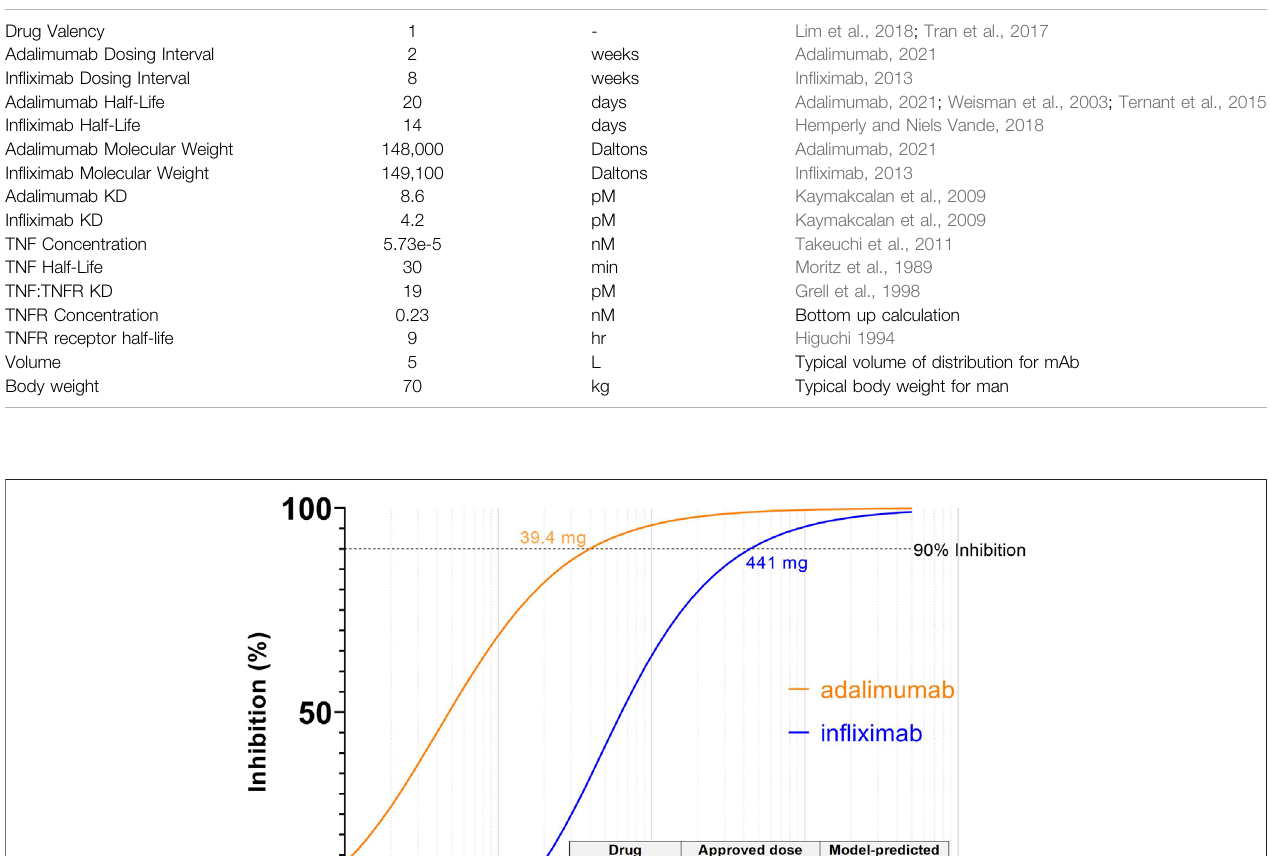
TABLE 2 | Adalimumab and in fl iximab (TNF α ) model parameters. Parameter